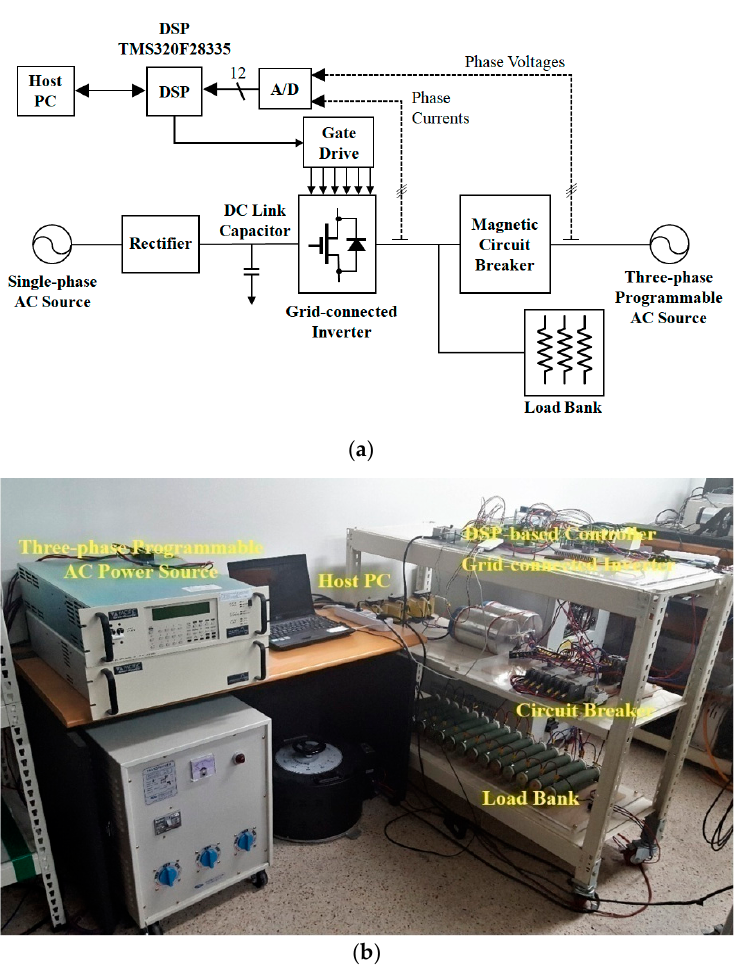
Figure 13. Experimental system. ( a ) Configuration of the overall system; ( b ) photograph of the experimental setup.